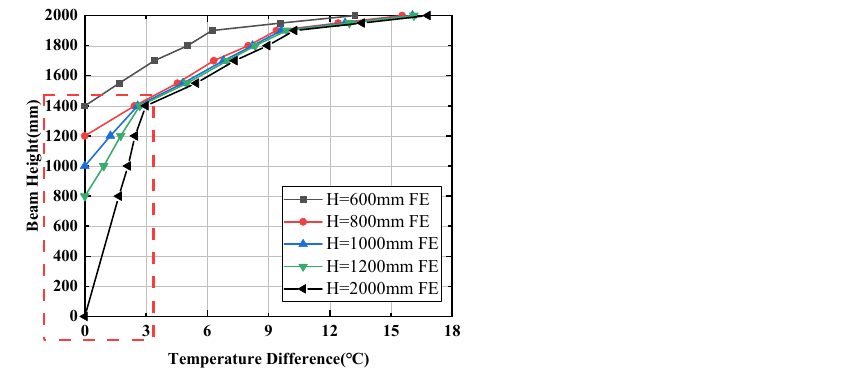
Figure 15. Change in temperature difference outside the range of 600 mm from the top plate.